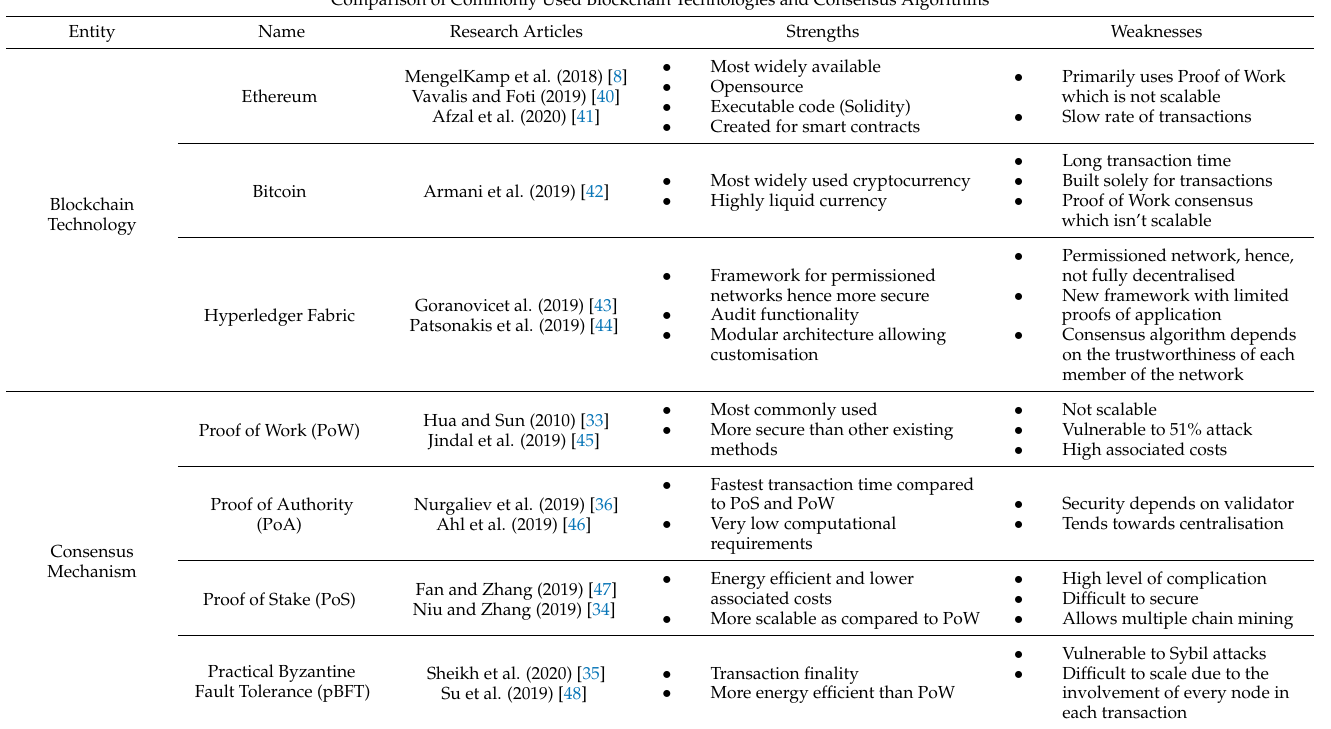
Table 4. Comparison of various blockchain technologies and consensus mechanism used in energy applications from the articles